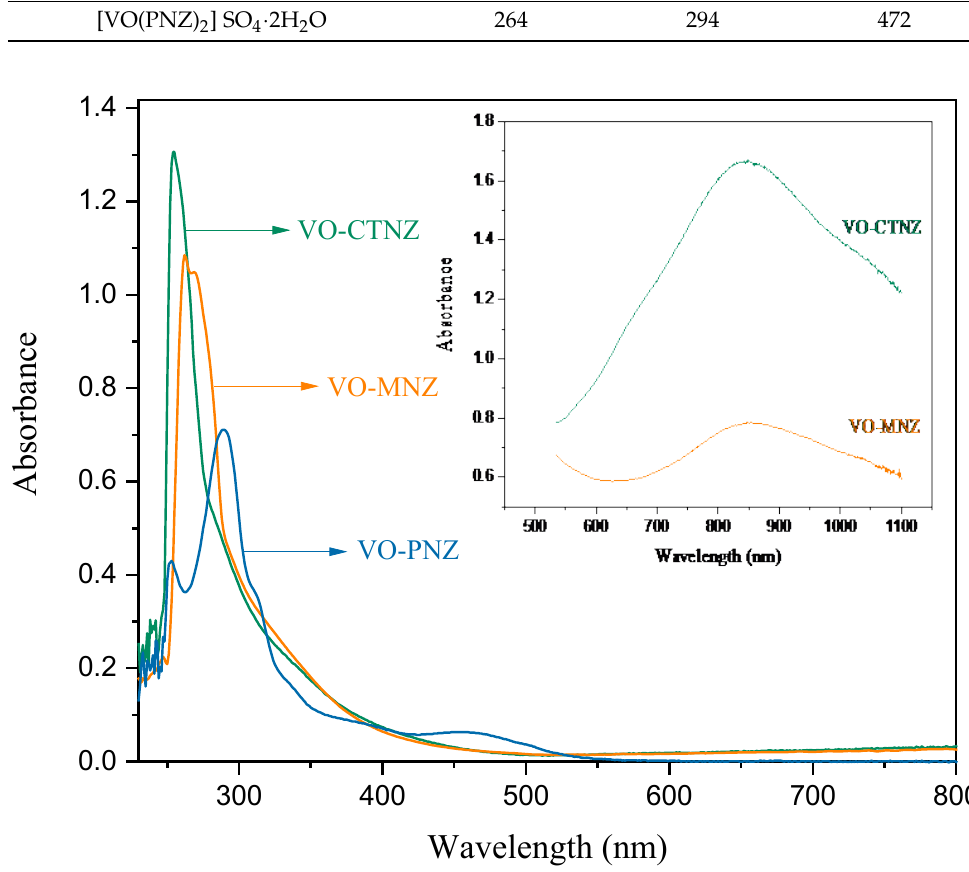
Figure 5. The UV-Vis spectra of synthesized oxidovanadium(IV) complexes in DMSO. Low-intensity peaks observed at higher wavelengths around 800 nm in VO-CTNZ and VO-MNZ are due to low-energy d–d transitions [34]. However, the electronic spectrum of VO-PNZ shows a shoulder band at 317 nm and a low-intensity band at 472 nm that may be attributed to LMCT, and the spin-allowed d–d electronic transitions, respectively